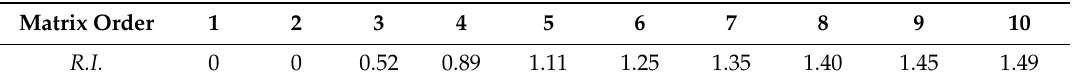
Table 2. Random index ( R.I. )